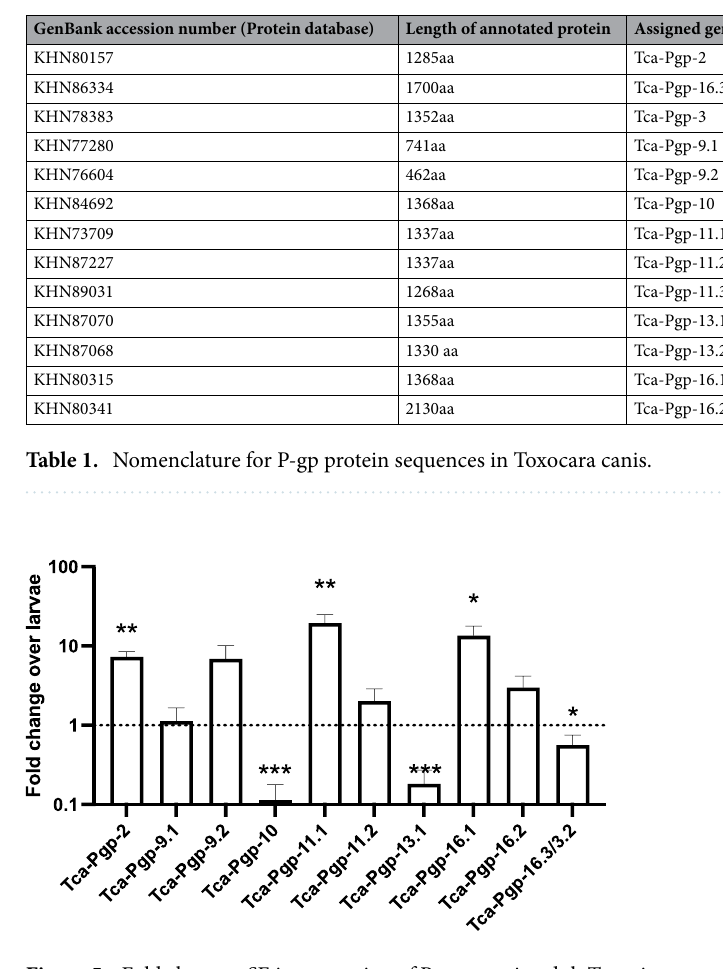
Figure 5. Fold change ± SE in expression of Pgp genes in adult T. canis worms compared to hatched larvae. Fold change was calculated using the efficiency corrected ΔCt method using T. canis 18S as the reference gene. Bars above the dotted line represent increased transcription in adults and bars below the line represent increased transcription in larvae. (Asterisks represent statistically significant differences, *** p < 0.001, ** p < 0.01, * p < 0.05).